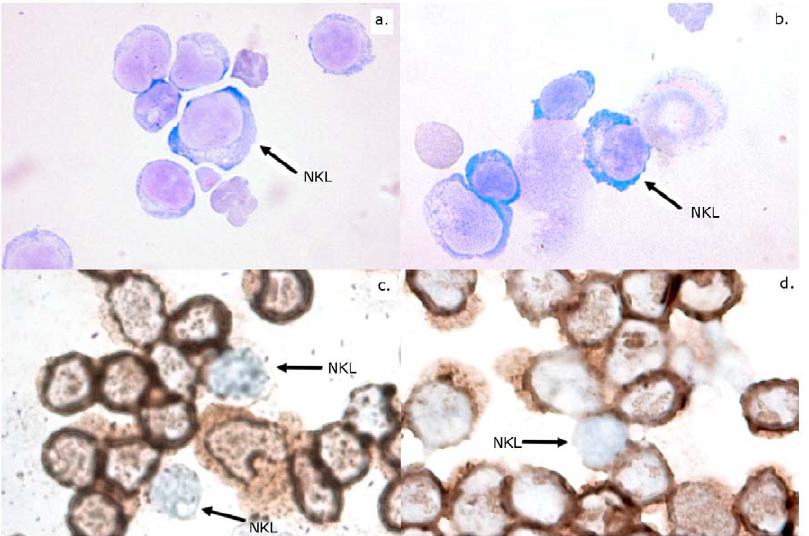
Figure 8. Giemsa staining and immunocytochemistry of Tasmanian devil peripheral blood MNC. Panels a and b show giemsa stained mononuclear cell preparations, in which NK like (NKL) large granular lymphocytes were present. Panels c and d show immunocytochemistry of mononuclear cell preparations with dual staining for CD3 and MHC II. Unlabelled NKL cells can be differentiated from other lymphocytes. Monocytes and neutrophils can be identified by